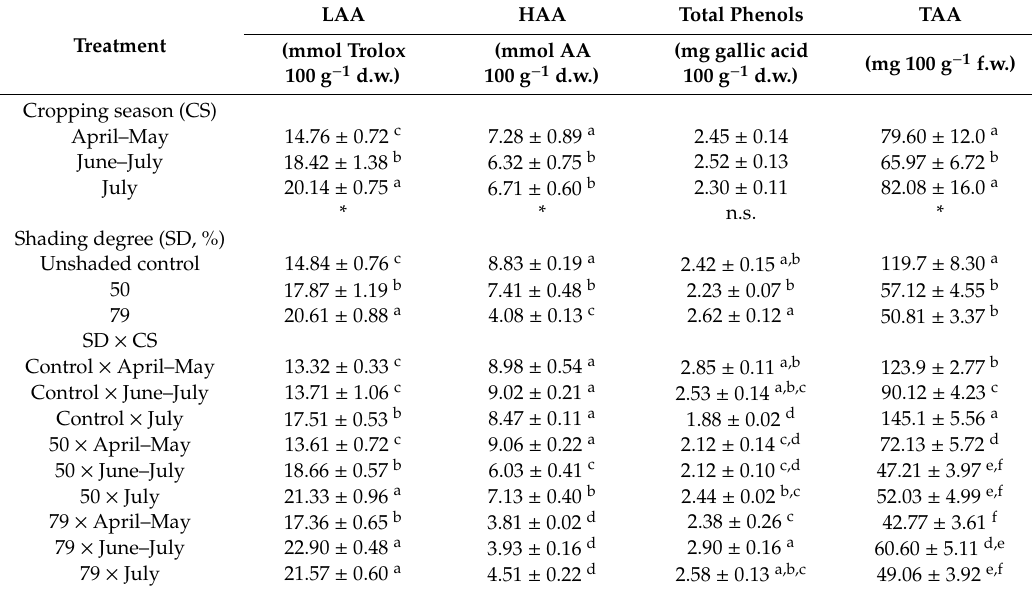
Table 5. E ff ect of the interaction between cropping season and shading degree on antioxidant compounds and activity of perennial wall rocket